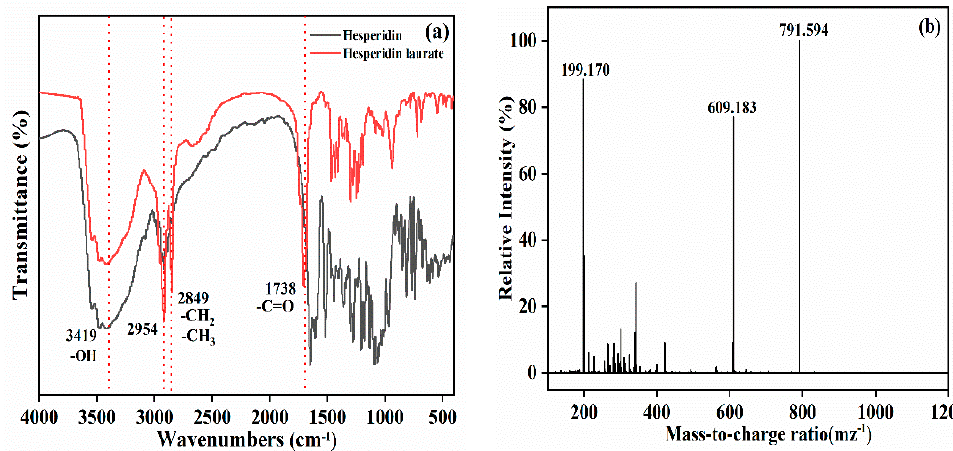
Figure 13. ( a ) FTIR spectra of hesperidin and hesperidin laurate, and ( b ) HRMS of hesperidin laurate.